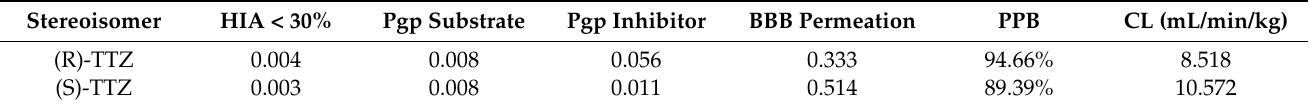
Table 3. Predictions regarding the absorption, distribution, and excretion of the stereoisomers of triticonazole (TTZ) in the human organism: HIA—human intestinal absorption, P-gp—permeability glycoprotein, BBB—blood–brain barrier, PPB –plasma protein binding,